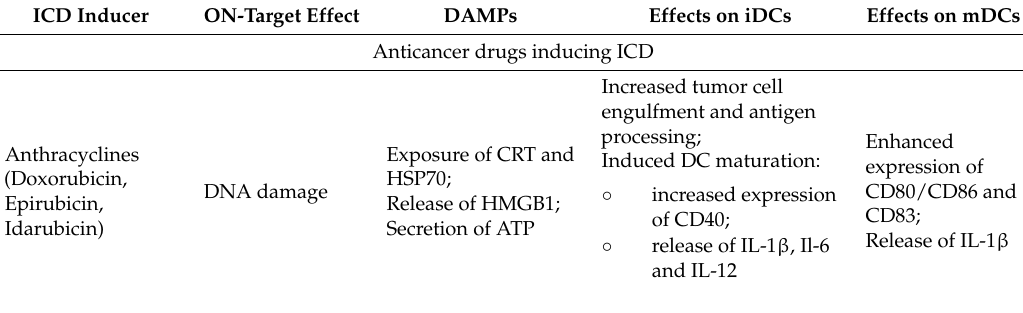
Table 1. Main immunogenic cell death (ICD)-inducers and their effects on immature dendritic cells (iDCs) and mature dendritic cells